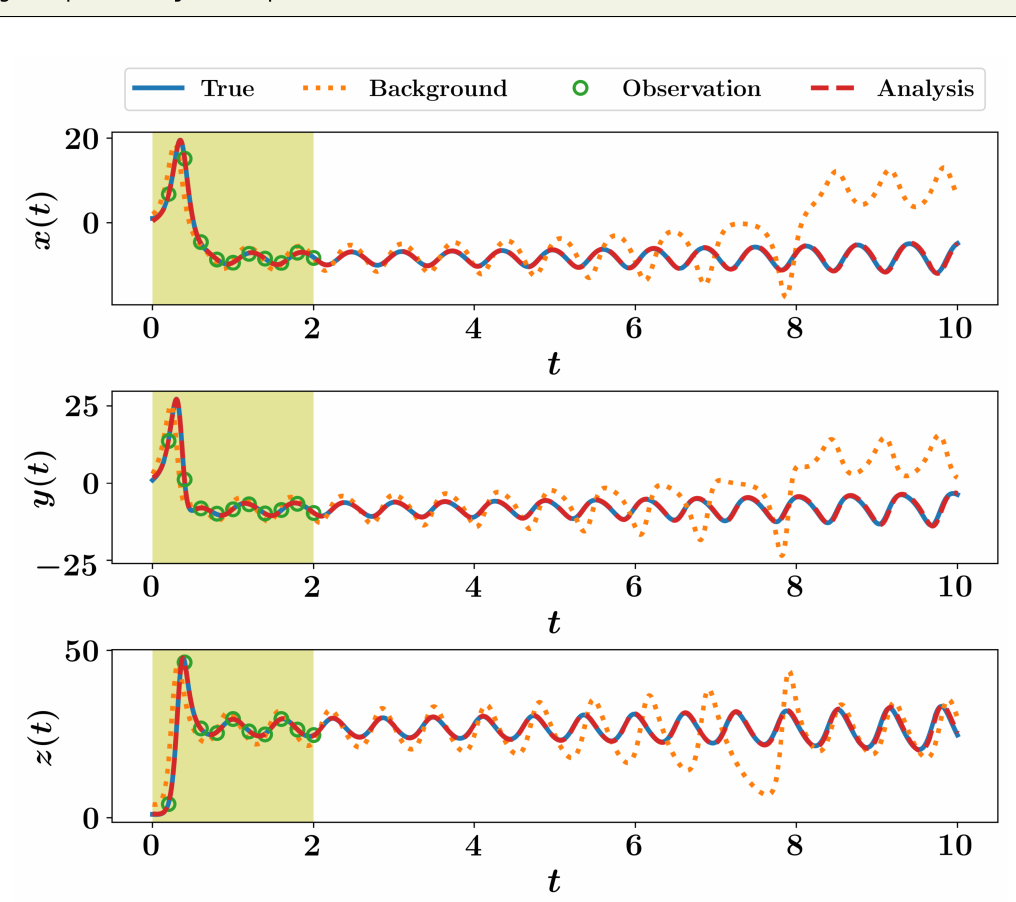
Figure 2. Results of 4DVAR implementation for the Lorenz 63